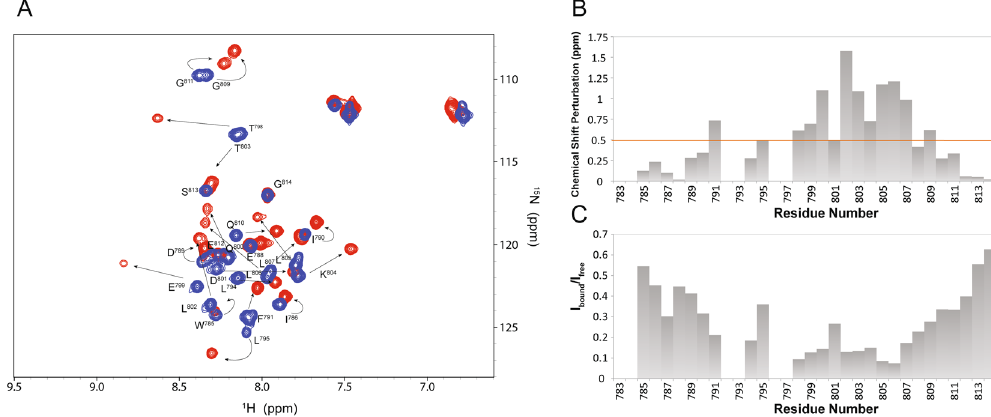
Figure 3. NMR analysis of STAT6 783–814 binding to NCoA1 PAS-B domain. ( A ) Overlay of the 1 H, 15 N-HSQC spectra of STAT6 783–814 in free form (blue) and in complex with the NCoA1 PAS-B domain (red). ( B ) Chemical shift perturbations (ppm) of STAT6 783–814 upon binding plotted versus the primary sequence; the orange line indicates the mean value. ( C ) Signal intensity ratios of STAT6 783–814 bound to NCoA1 PAS-B domain (I bound ) and free (I free ).